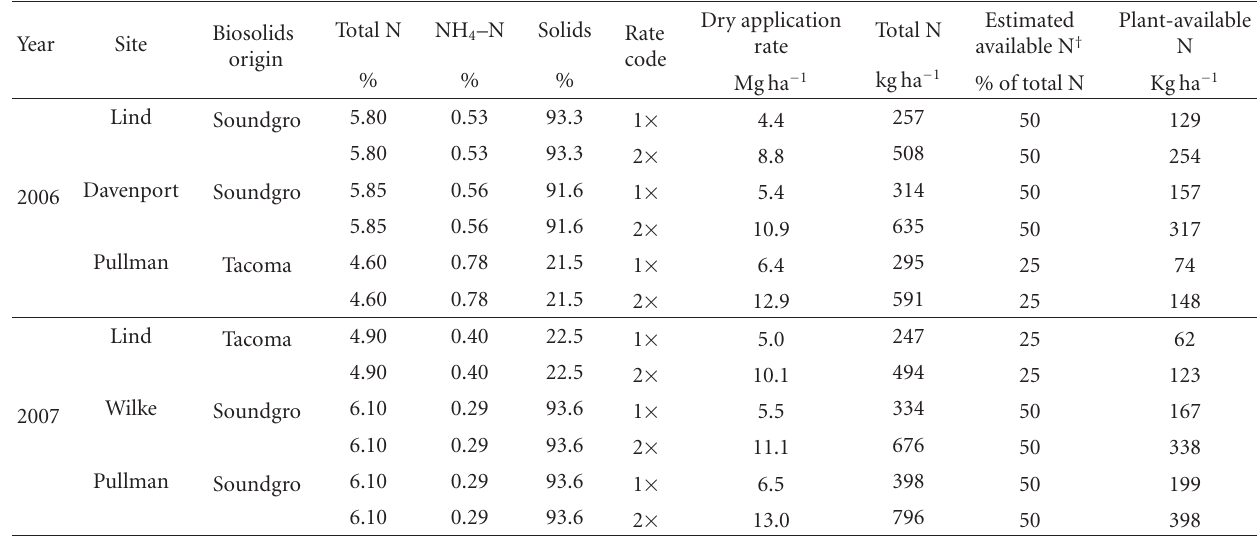
Table 2: Biosolids total N, ammonium (NH 4 )–N, solids content and material, and N application rates for each site-year. Soundgro and Tacoma are two biosolids products produced in the Seattle, Washington metropolitan